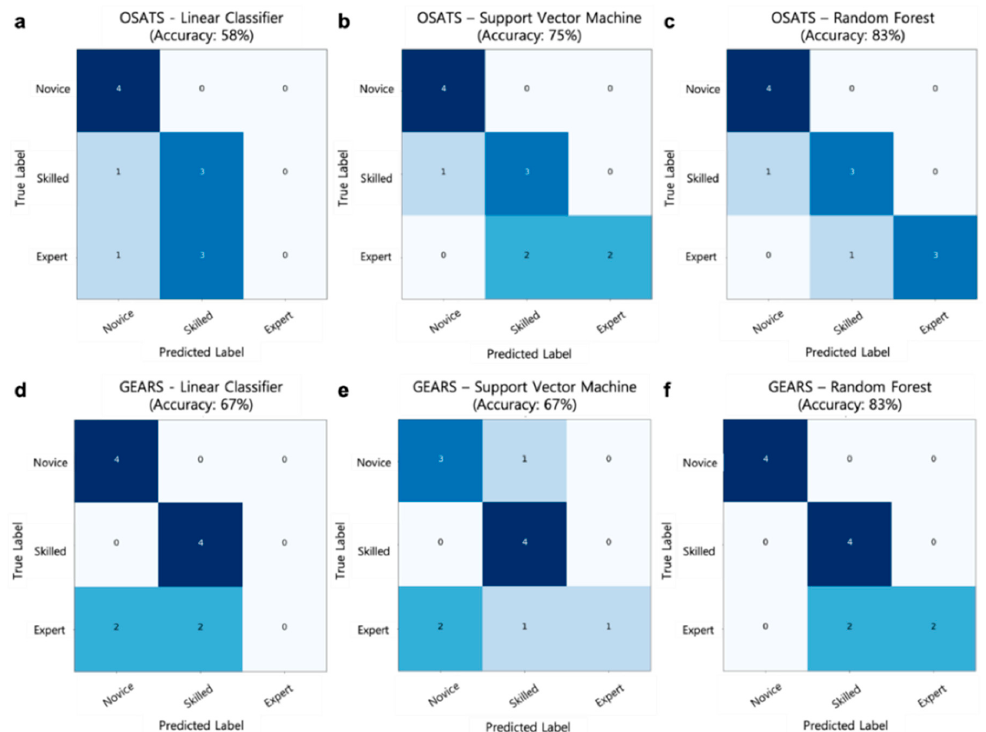
Figure 5. Comparison of the performance of surgical skill prediction models and parts of items in Object Structured Assessment of Technical Skills (OSATS) and Global Evaluative Assessment of Robotic Surgery (GEARS) with a confusion matrix. The test dataset consisted of four novice, four skilled, and four expert surgeons. ( a – c ) Confusion matrix results of models using the OSATS. ( a ) Linear classifier; ( b ) support vector machine; and ( c ) random forest. ( d – f ) Confusion matrix results of models using the GEARS. ( d ) Linear classifier; ( e ) support vector machine; and ( f ) random forest.